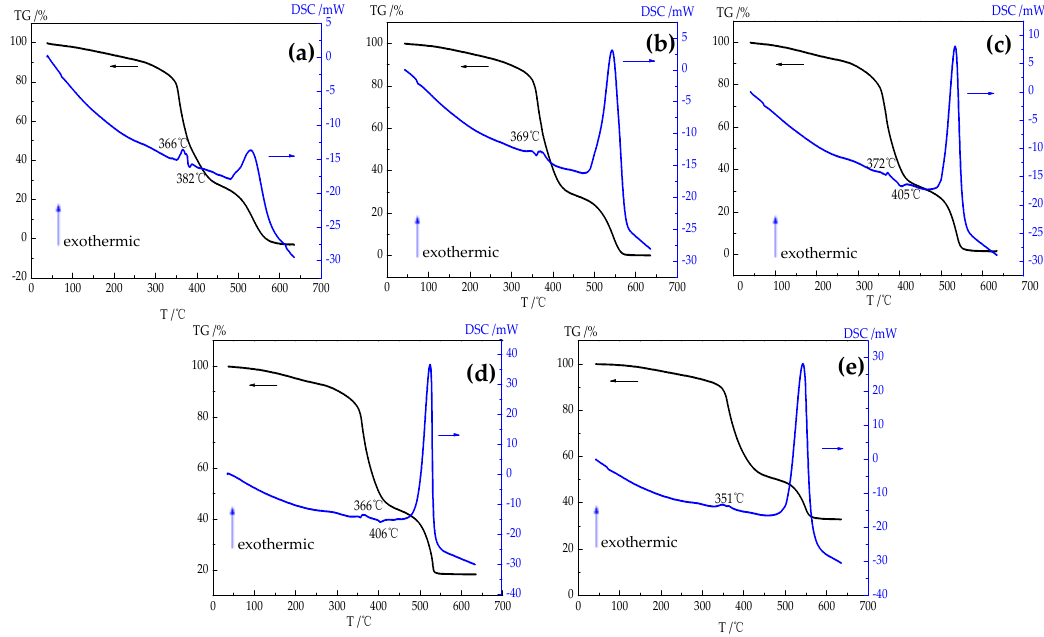
Figure 7. TG-DSC test of the pure epoxy and nanocomposites in air. ( a ) 0 wt %; ( b ) 7 wt %; ( c ) 15 wt %; ( d ) 25 wt %; and ( e ) 40 wt %.